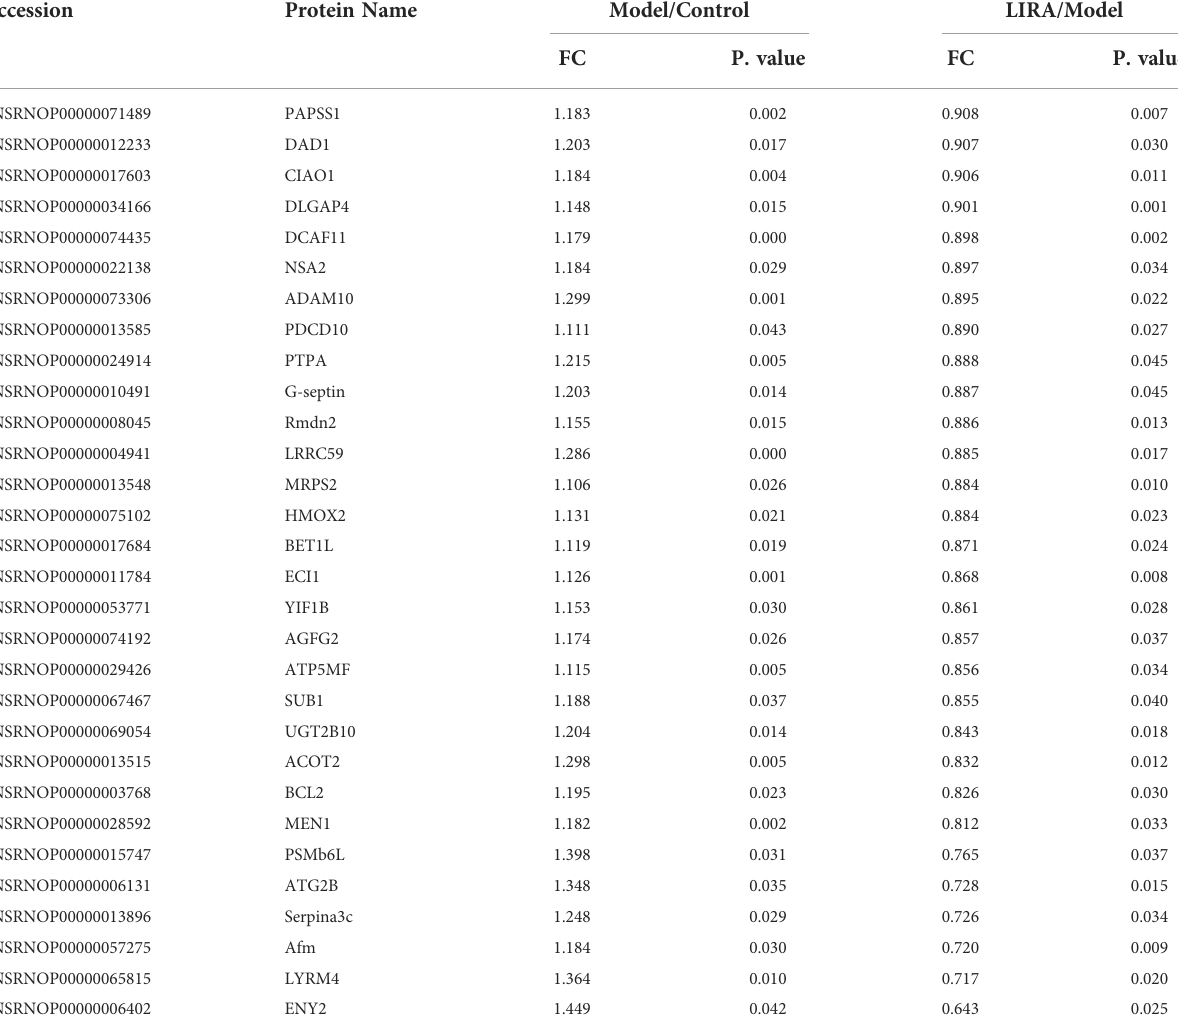
TABLE 1 Down-regulated pancreatic DEPs in LIRA compared with Model rats (n=3). Accession Protein